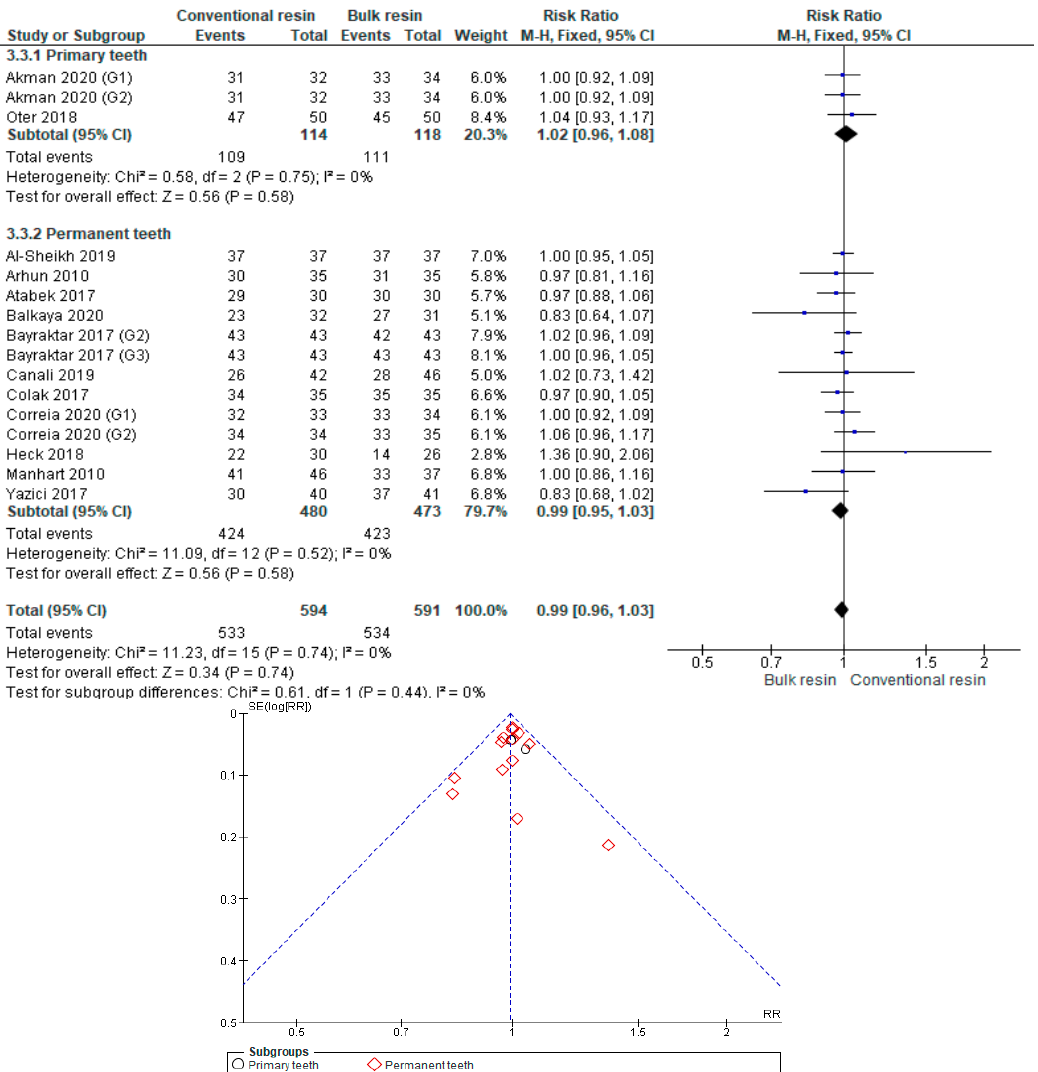
Figure A13. Adequate Marginal Adaptation: Conventional Resin versus Bulk Resin According to Type of Teething.